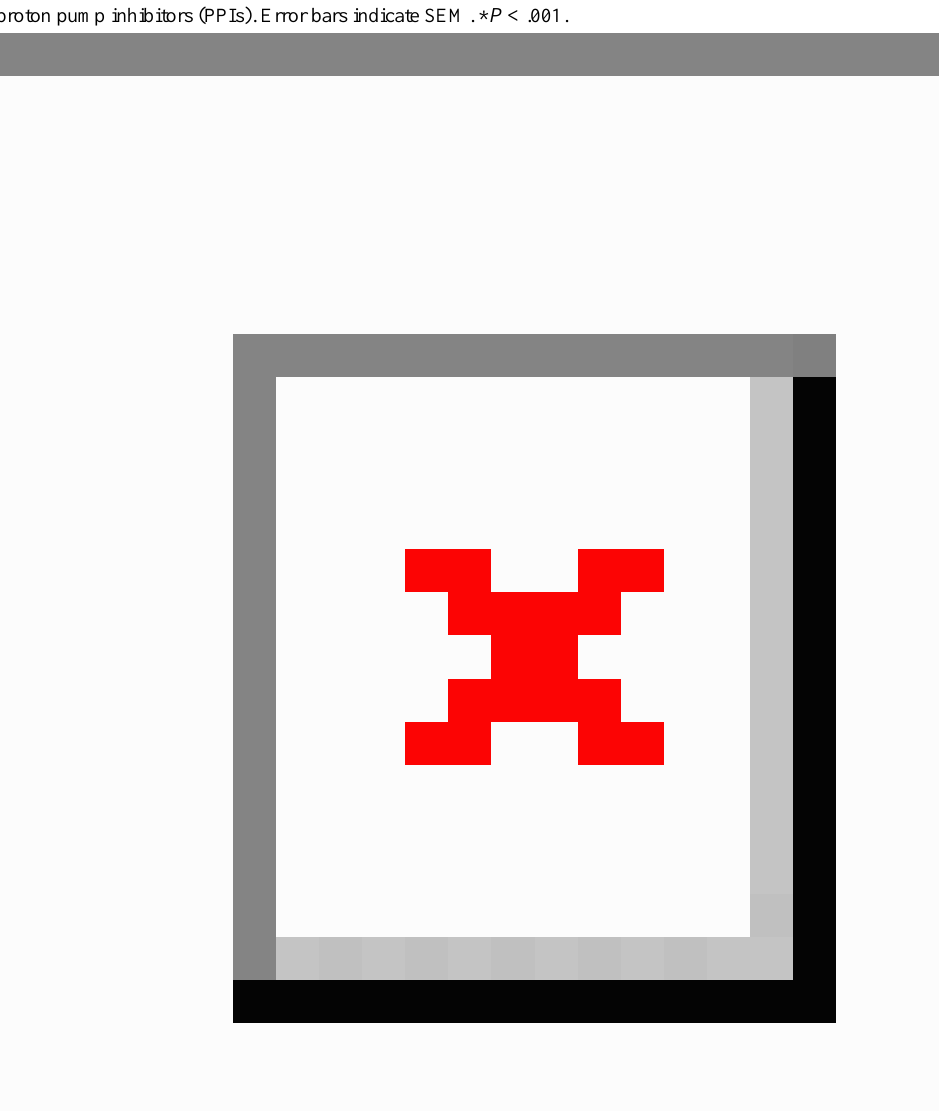
Figure 2. Quality of Life in Reflux and Dyspepsia (QOLRAD) scores by domain in respondents with gastroesophageal reflux disease (GERD)